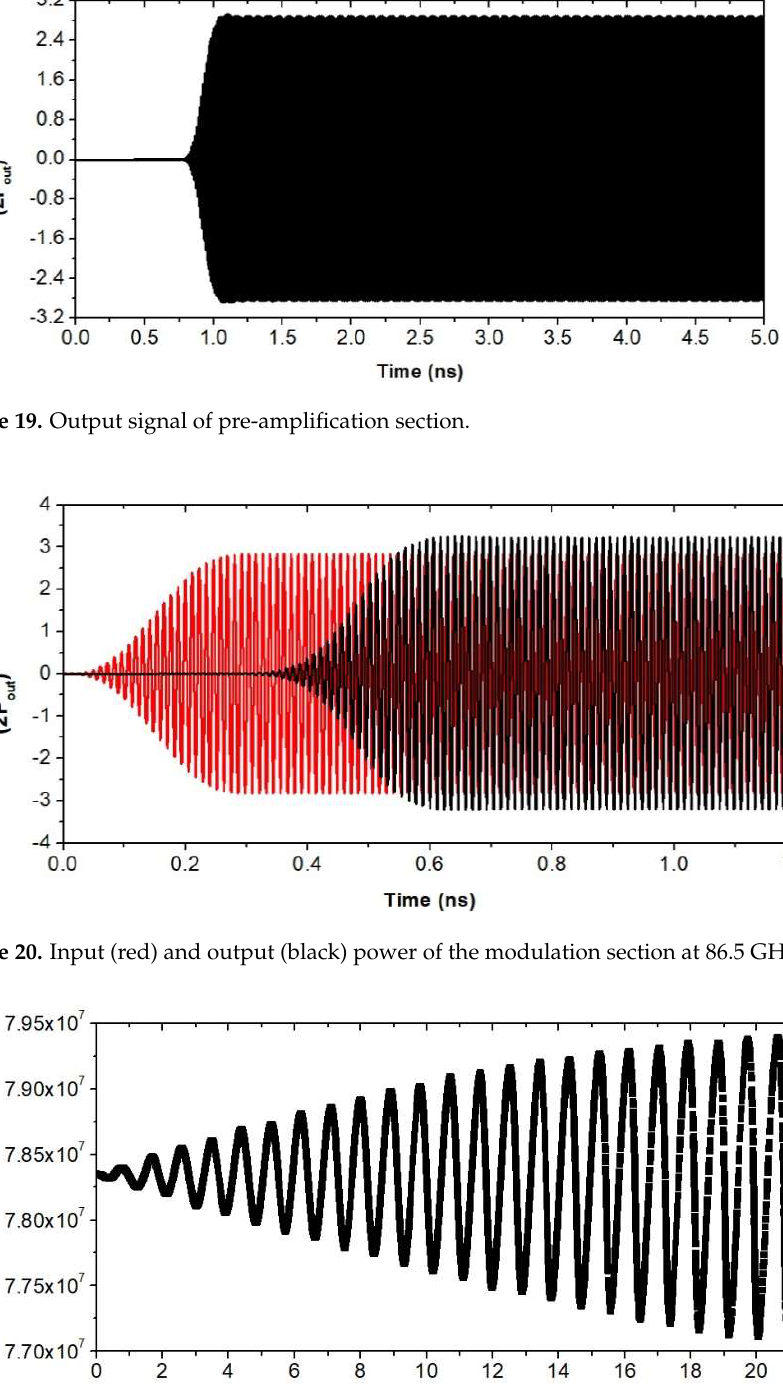
Figure 19. Output signal of pre-amplification section.